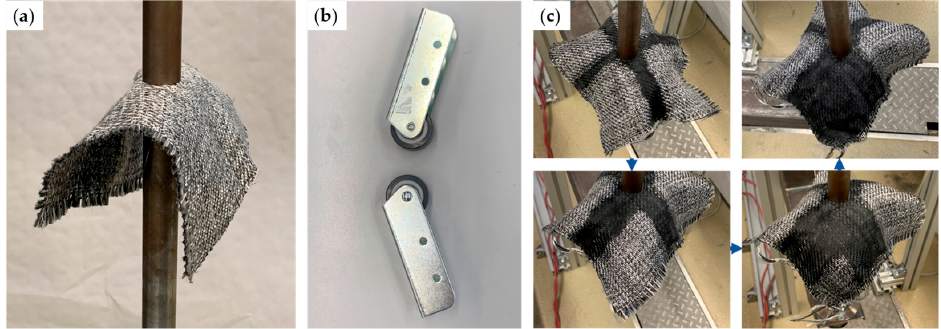
Figure 17. ( a ) Commingled yarn weave clamped between two poles; ( b ) Roller tools used for dieless forming and consolidation; ( c ) Forming sequence of dieless commingled thermoplastic forming.